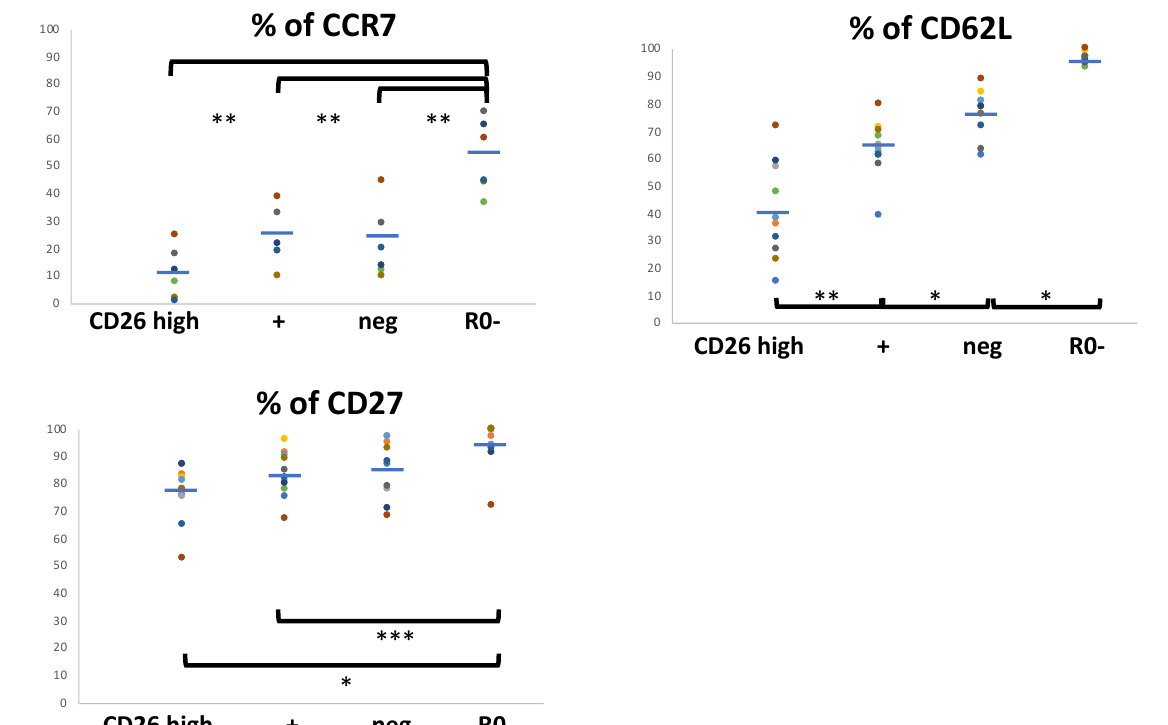
Figure 2. Phenotypes of central (CM) and effector/memory (EM) in CD4 T cell subsets defined with CD26 and CD45R0